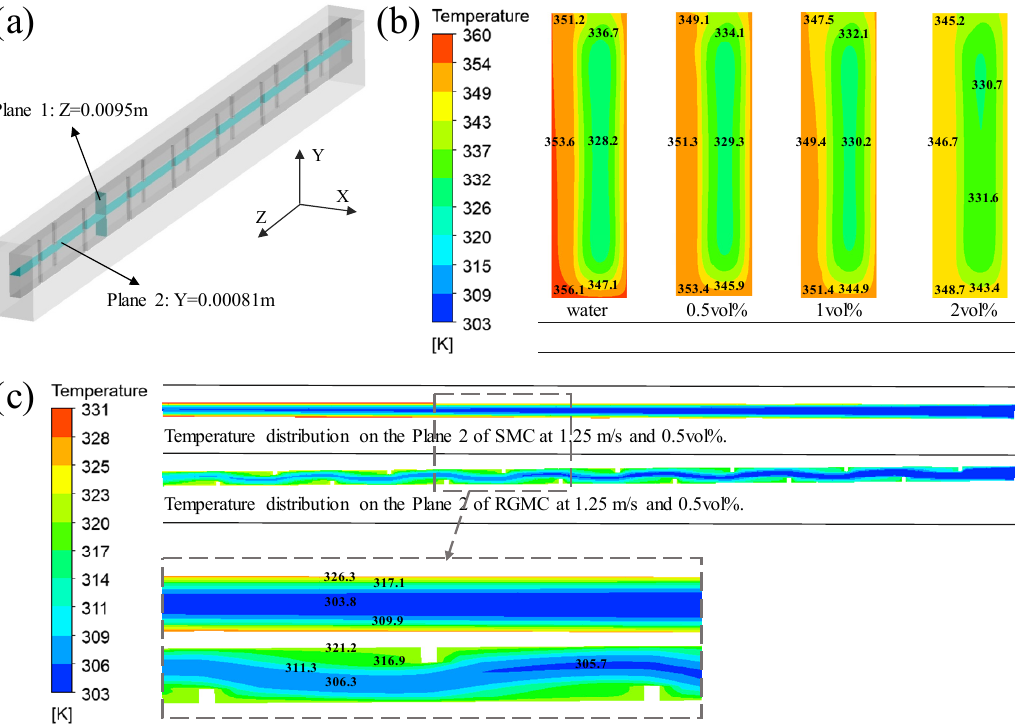
Figure 6. ( a ) Two planes in the microchannel fluid domain. ( b ) The temperature distribution on the Plane 1 of RGMC at 0.25 m/s with different volume fractions. ( c ) The temperature distribution on the Plane 2 of different microchannel at 1.25 m/s with volume fraction 0.5%.